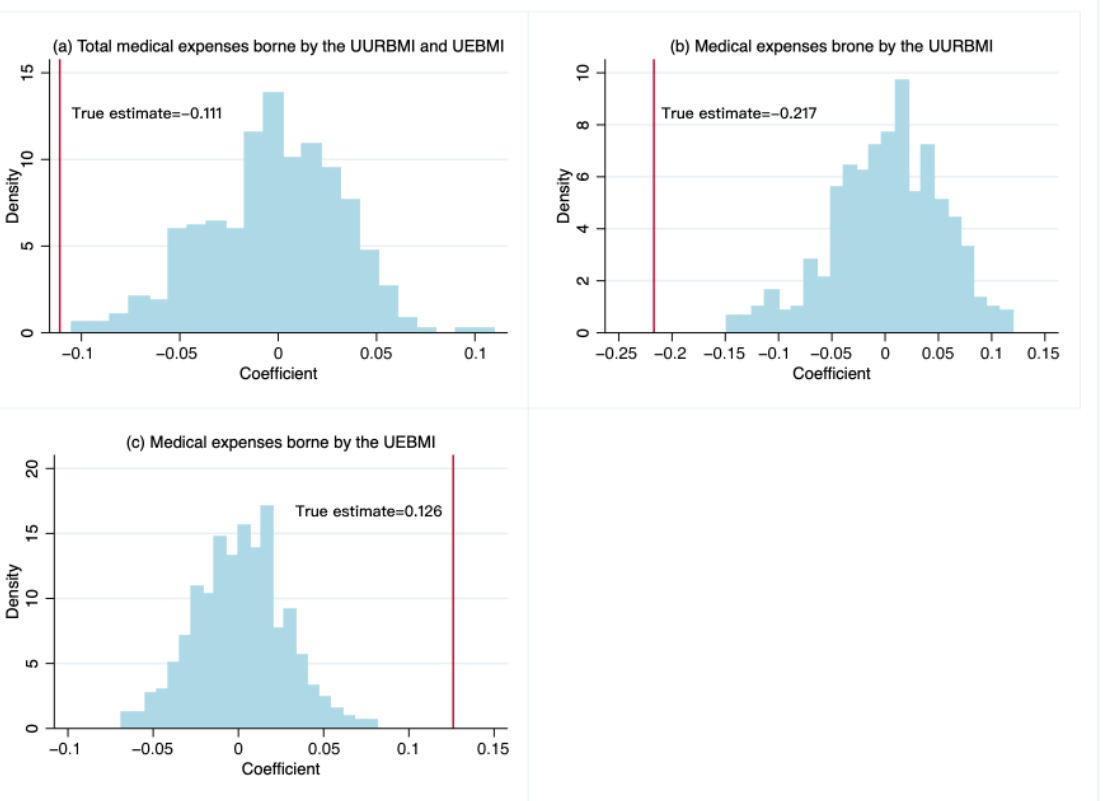
Table 8. Mechanism test: air pollution.